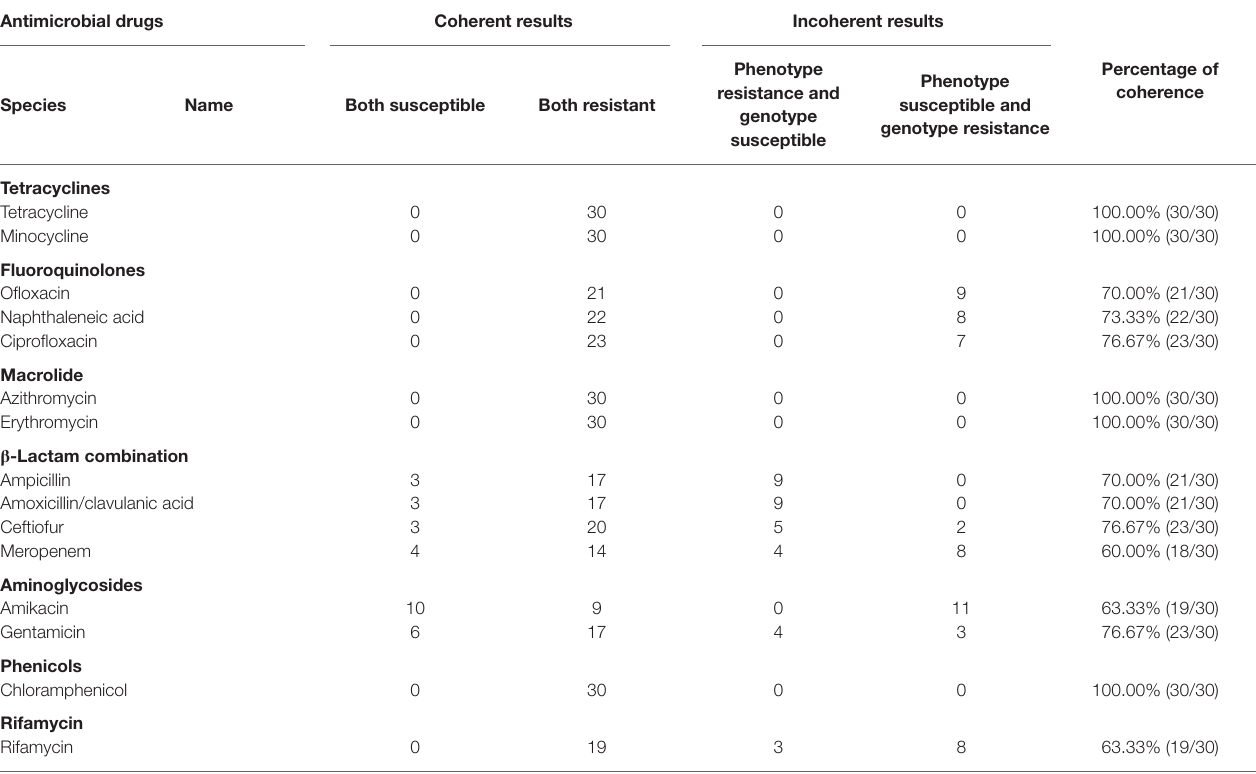
TABLE 3 | Phenotypic and genotypic analyses of antimicrobial resistance of P. mirabilis isolates.